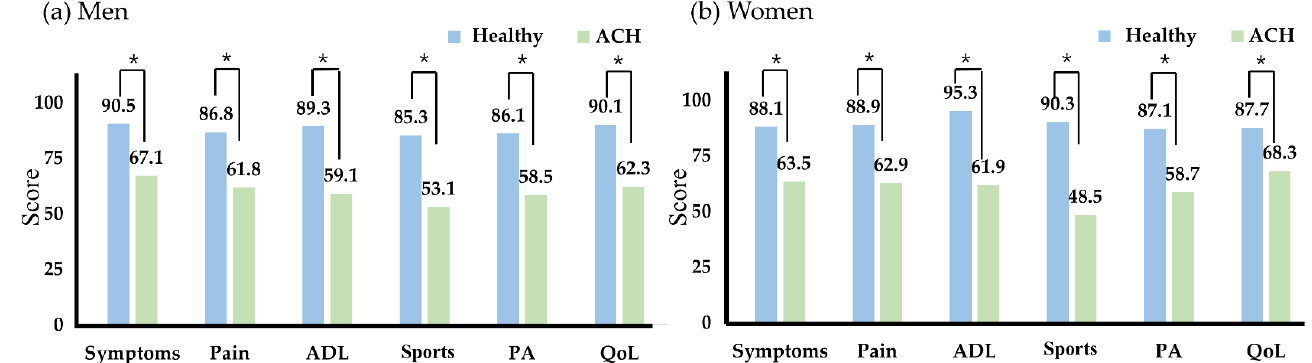
Figure 4. Subjective hip scoring with HAGOS. * p < 0.05; abbreviations: ACH, adhesive capsulitis of the hip; HAGOS, hip and groin outcome scale; ADL, activities of daily living; PA, physical activities; QoL, quality of life.